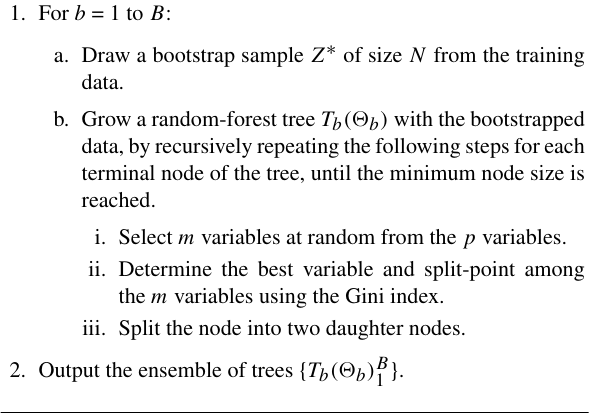
Algorithm 1 Random forest algorithm for